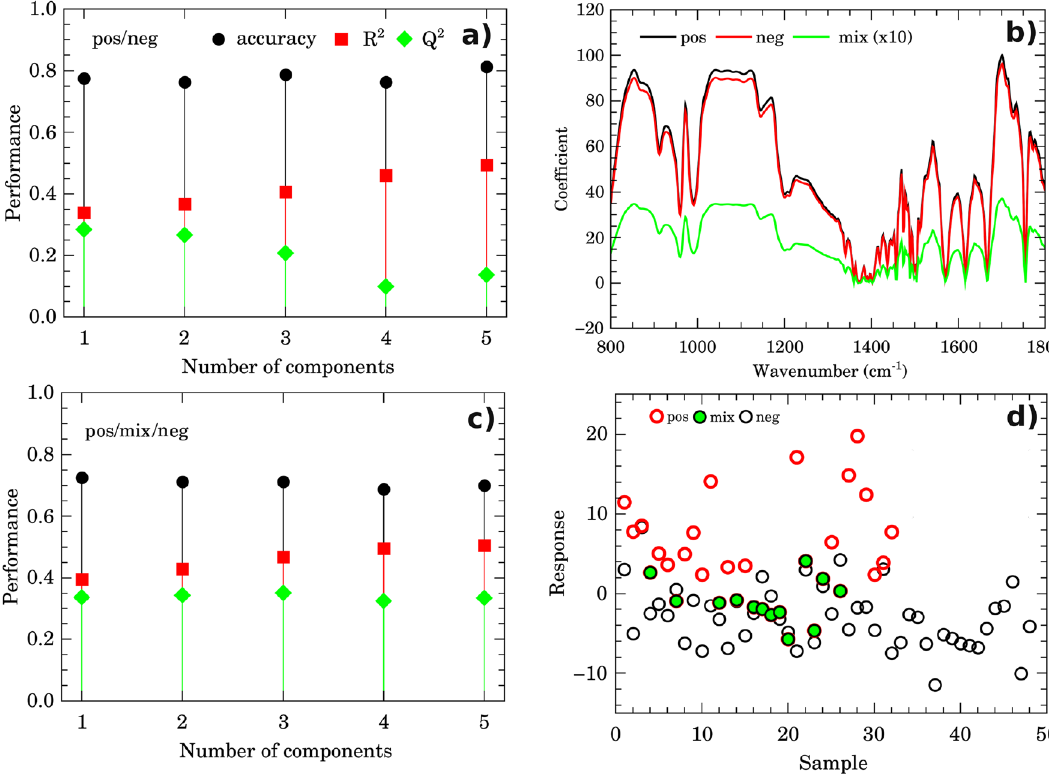
2 2 and Q criteria for two (positive/negative, ( a ) and three (positive/